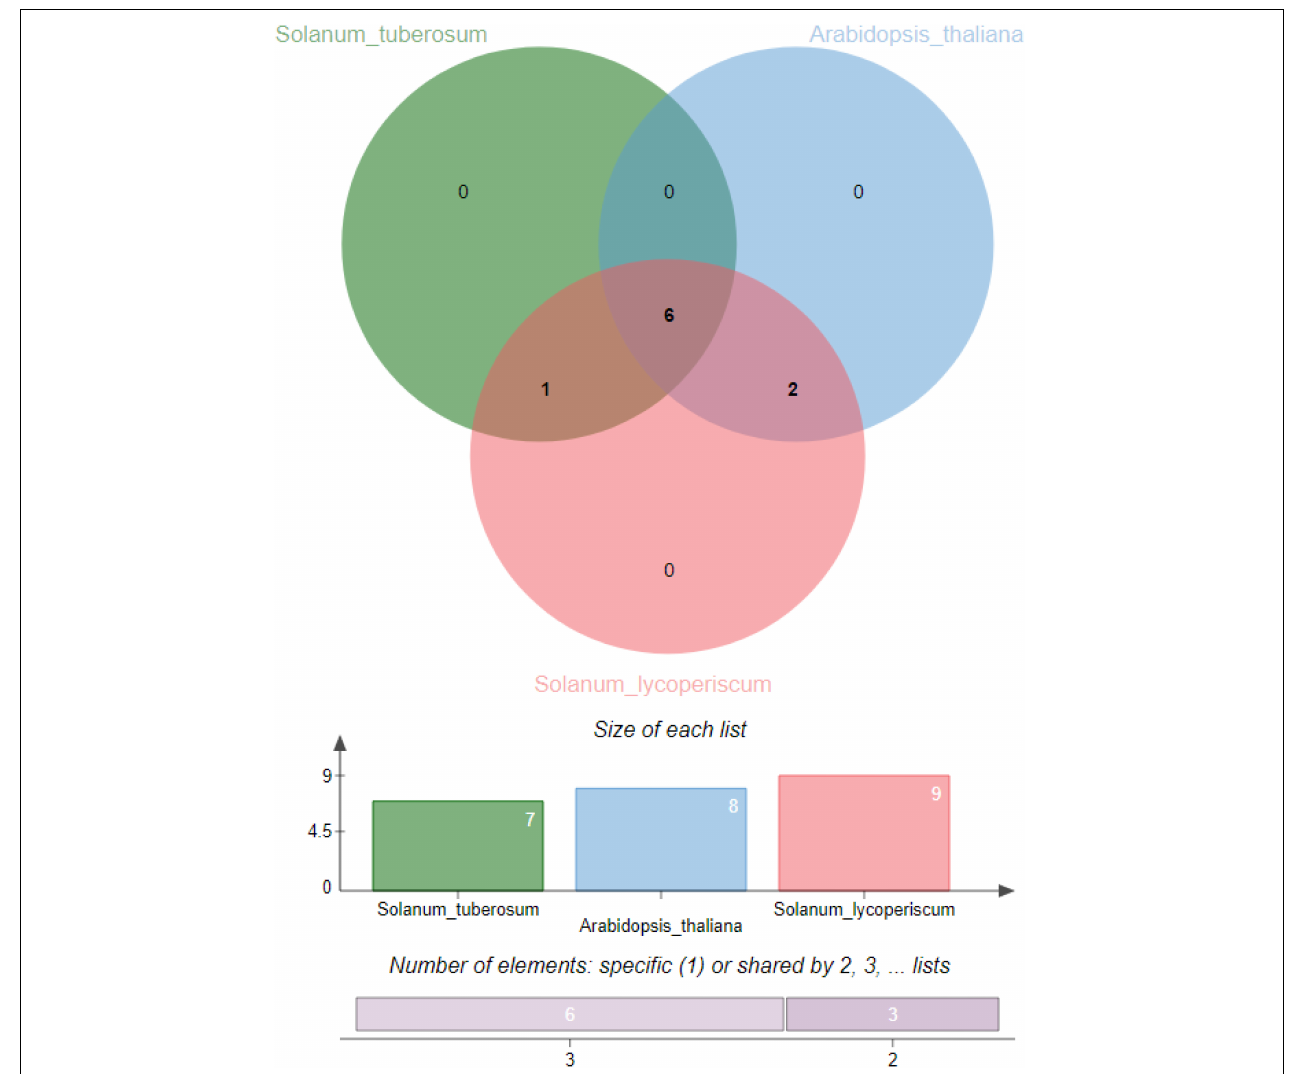
FIGURE 5 | Identification of orthologous gene clusters in potato, tomato, and Arabidopsis genomes.